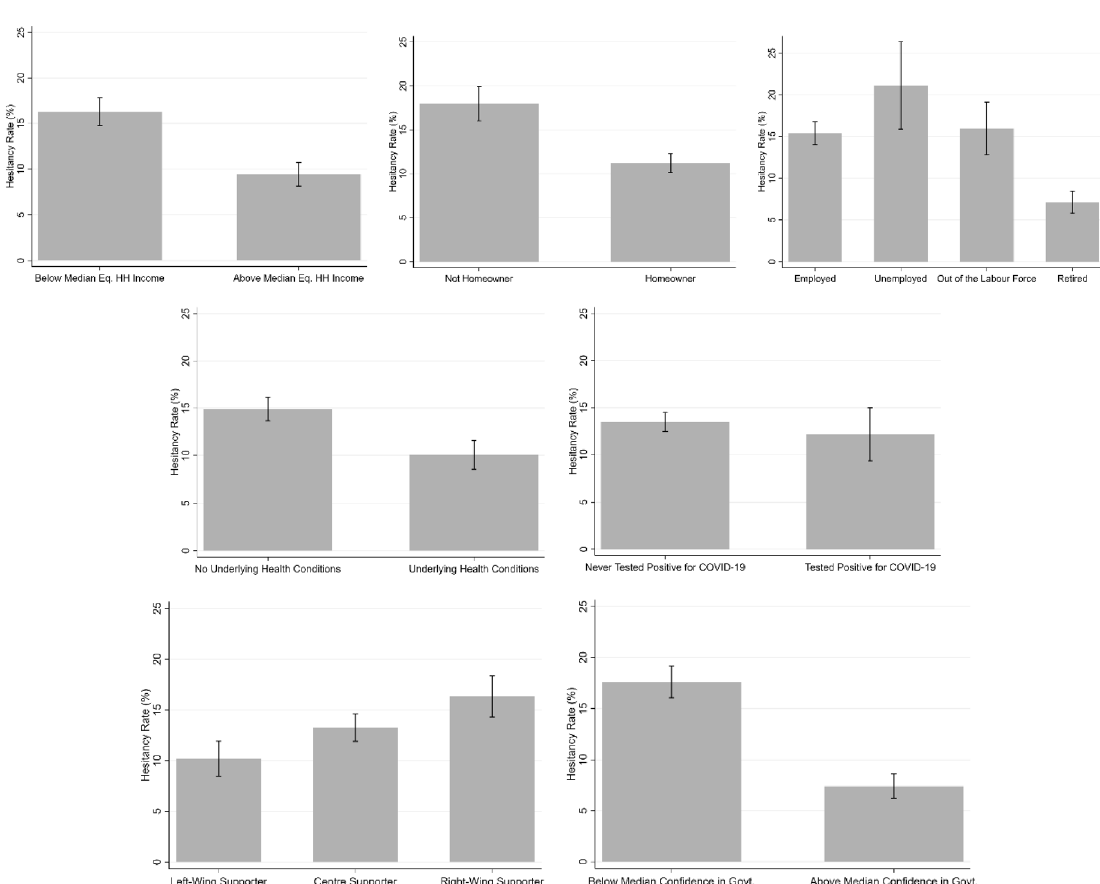
Figure 2. Vaccine hesitancy: other individual characteristics. Notes : These figures refer to our estimation sample. The grey bars show the percentage of vaccine-hesitant in each group, and the intervals refer to the 95% confidence